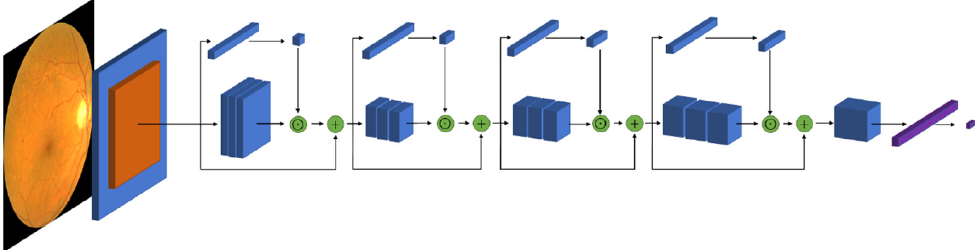
Figure 1. Architecture of the neural network. Only one block per each sequence is showed.